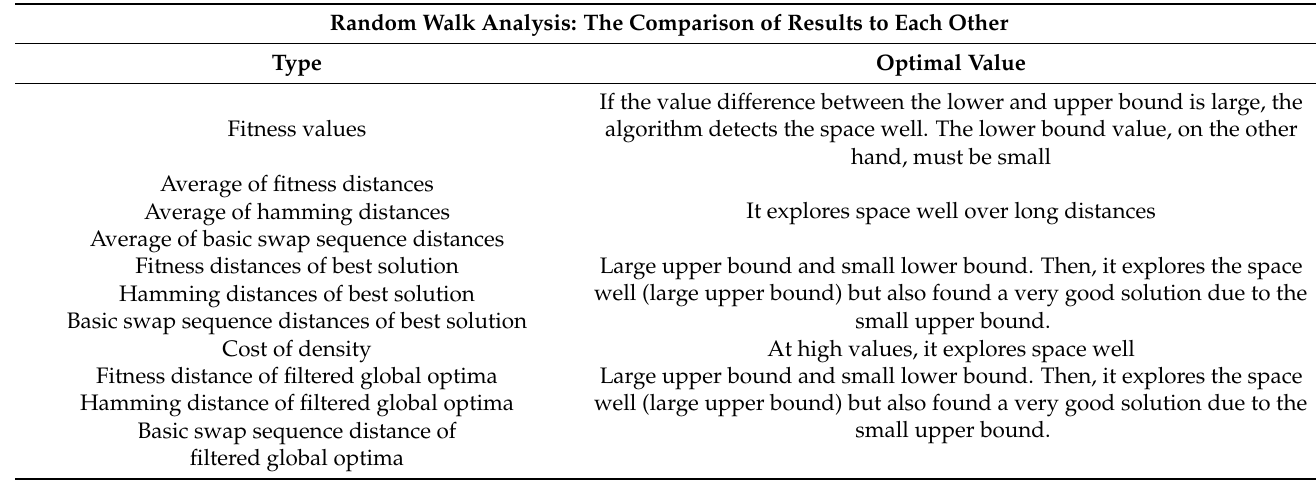
Figure 15. The cost of density in case of cycle crossover ( a ) and partially matched crossover operator ( b ). Table 3. The evaluation methods of the results of random walk analysis.